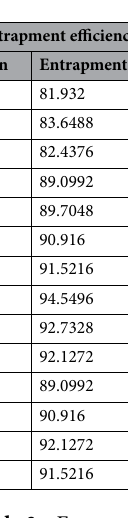
Table 3. Entrapment efficiency